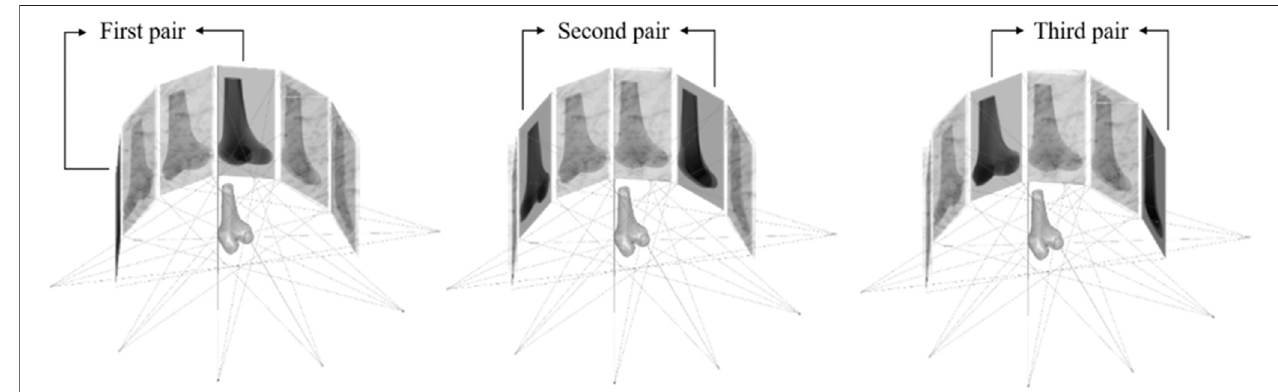
FIGURE3| IllustrationoftheviewsofsimulatedX-rayimagesforthreeimagepairconditions.The fi rstimagepairwasobtainedfromthestartingreferencedetector position. The second and third image pairs wereobtained byrotatingthe bi-plane fl uoroscopearound the isocenter from the reference detector position by30 ° and 60 ° ,